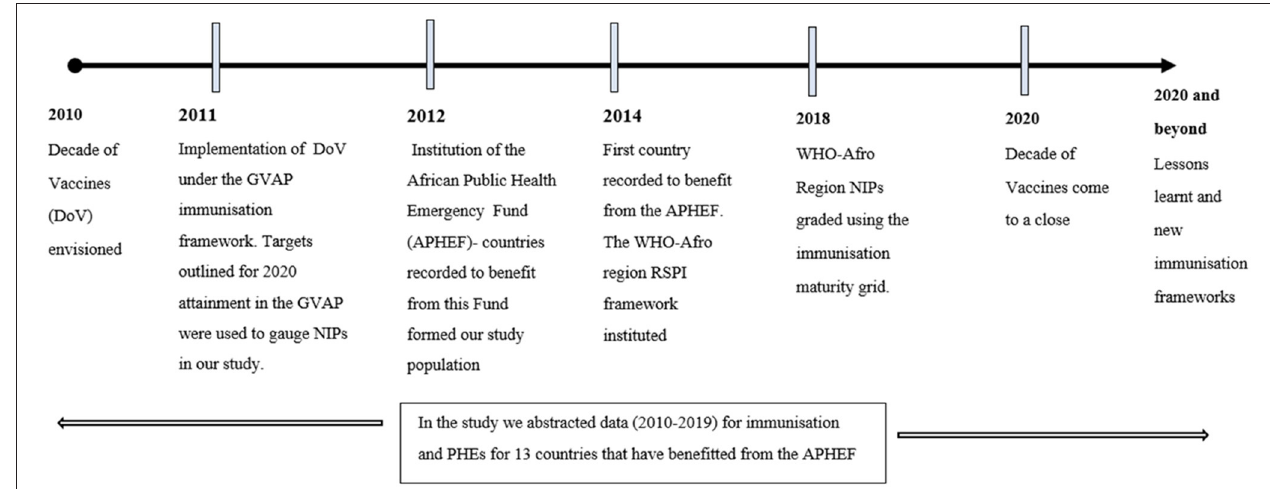
FIGURE 1 | A conceptual framework of initiatives used to inform the choice of the study variables.